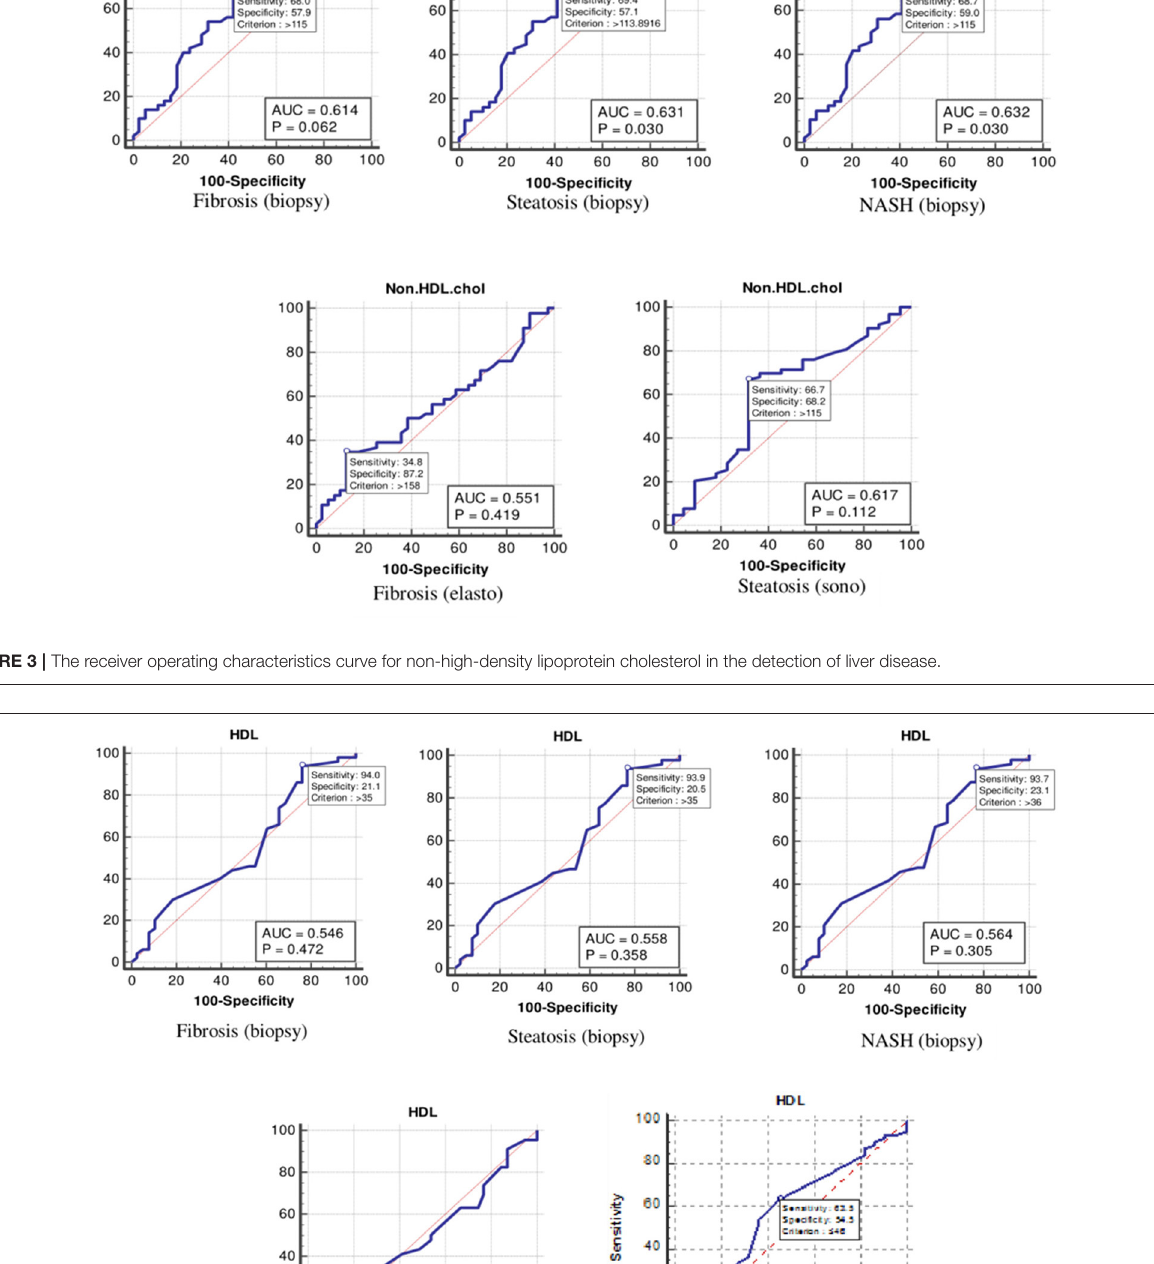
Frontiers in Cardiovascular Medicine |